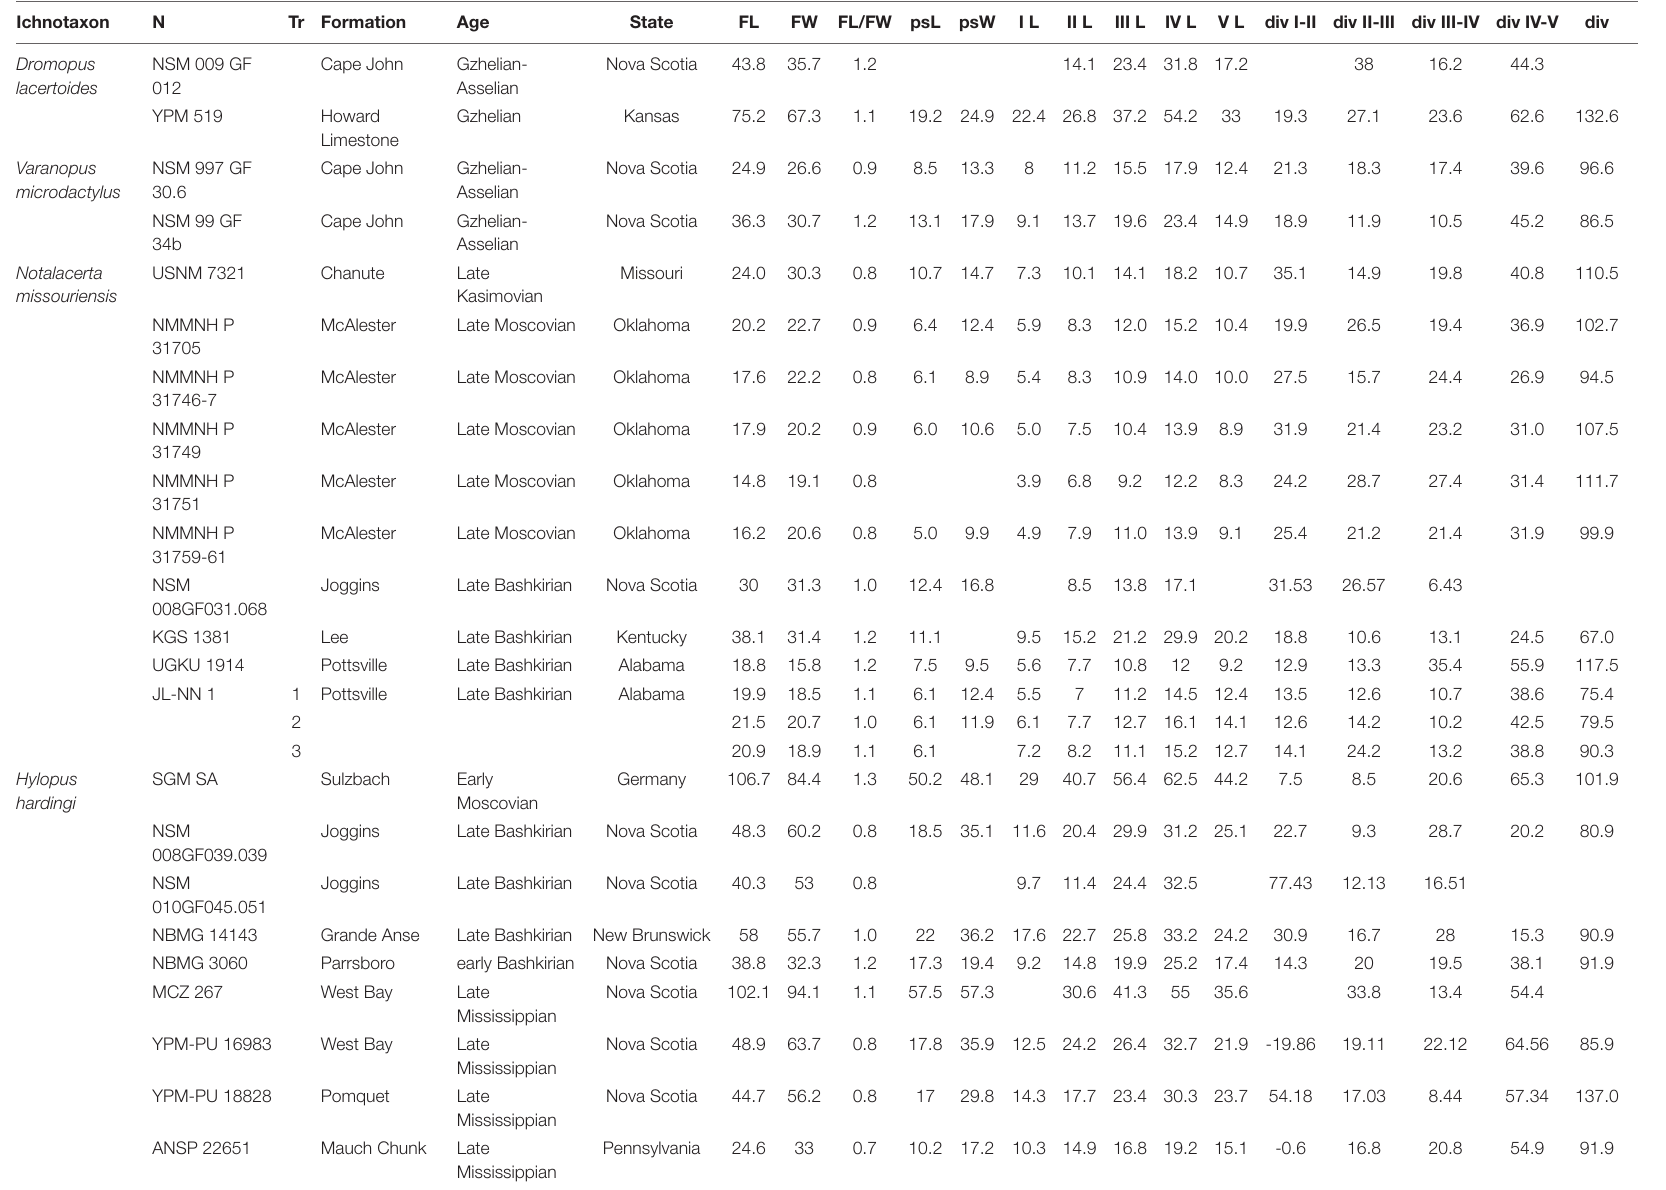
TABLE 1 | Ichnological parameters of pedal footprints.